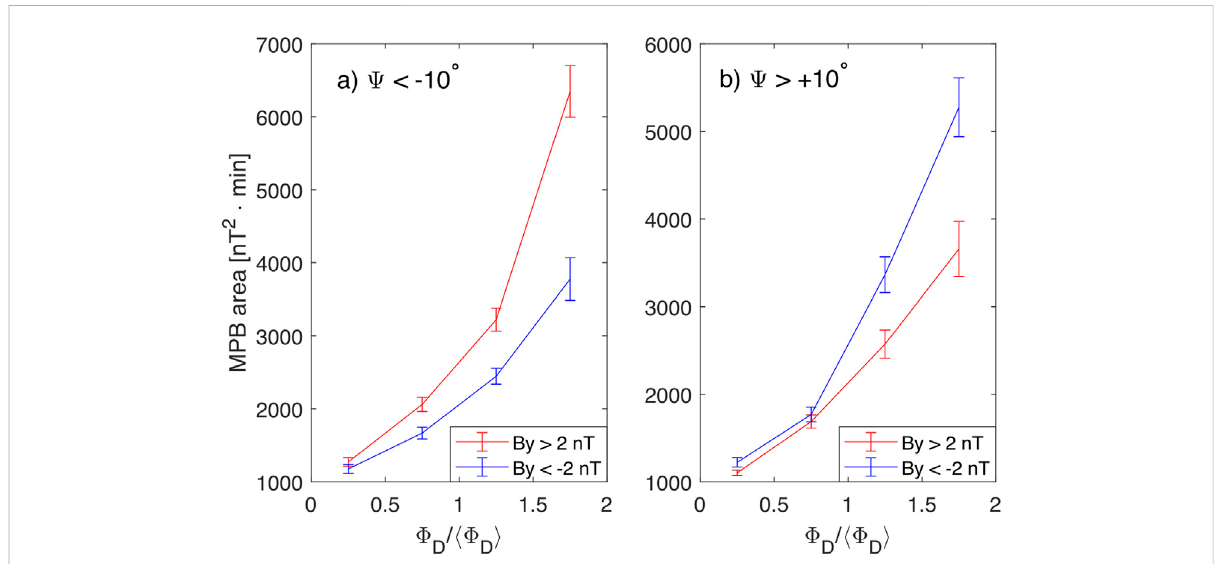
FIGURE 2 TheMPBpulseareaasafunctionofthenormalized Φ D parameterseparatelyforB y > 2nTandB y < − 2nT.Theerrorbarsindicate±onestandard deviation of the median. Left: Negative dipole tilt. Right: Positive dipole tilt.